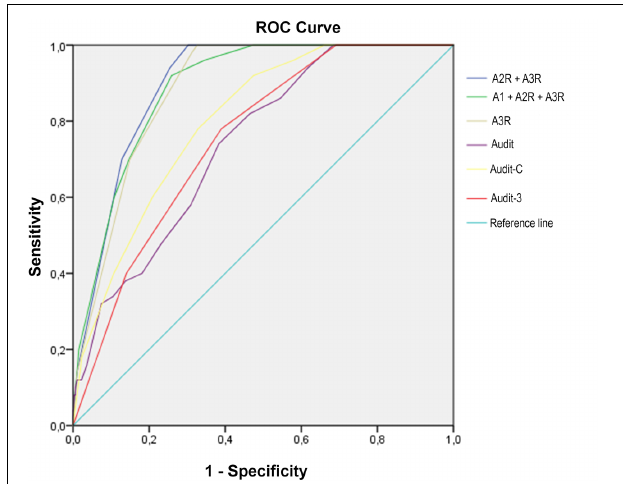
FIGURE 1 | Receiver operating characteristic (ROC) curves for all AUDIT versions to detect